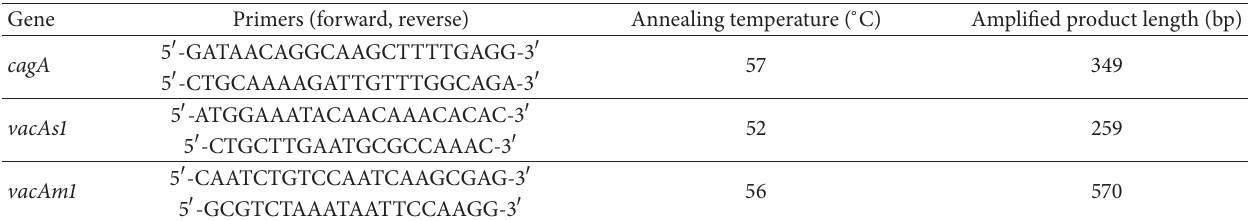
Table 1: Primers and PCR